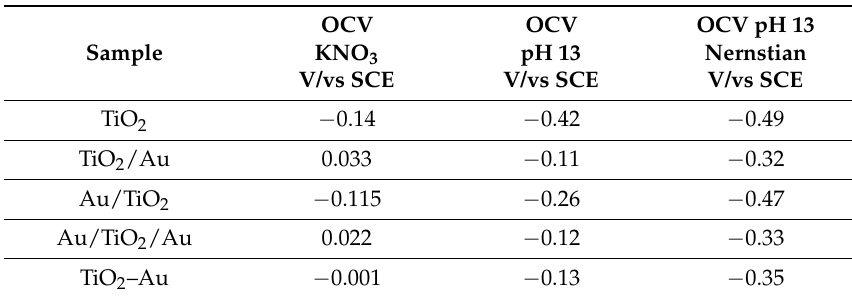
Table 3. Open circuit voltage (OCV) values measured at different samples, under different pH. The values of OCV at pH 13, calculated by E = E 0 − 2.3 RT/F pH, supposing a Nernstian behavior of the surface, are also reported as a